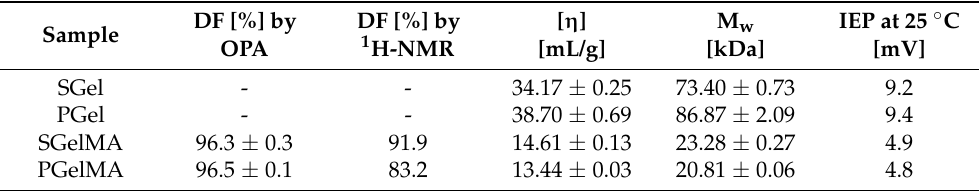
Table 2. Degree of functionalization (DF), Intrinsic viscosity [ η ] and average molecular weight (Mw) values determined by capillary viscometry, and isoelectric point (IEP) values for different gelatin and GelMA samples. Values are presented as average ± standard